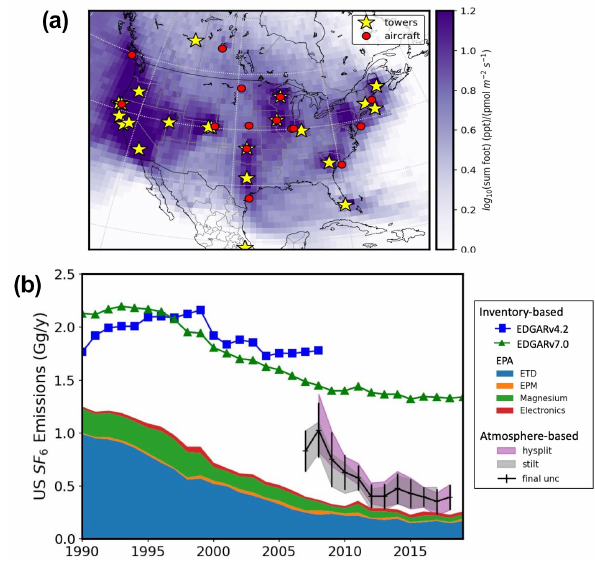
Figure 1. US SF 6 emissions derived from atmospheric observa- tions and reported by inventories. (a) Locations of atmospheric SF 6 measurements considered in the regional inversions; tower-based sampling is indicated as stars and airborne-profile sampling is de- noted as circles. Sensitivity of the atmospheric SF 6 measurements to surface emissions is indicated on a log10 scale as purple shading. (b) US SF 6 emissions reported by EDGAR (v4.2 and v7.0) and EPA inventories and derived from atmospheric observations. National to- tals are shown from EDGARv7.0, whereas the EPA inventory is parsed out by sector, including electric power transmission and dis- tribution (ETD), electrical equipment manufacturing (EPM), mag- nesium production, and electronics. Atmosphere-based emission es- timates for the contiguous United States (CONUS) are derived with two different model analyses of the atmospheric observations us- ing two different transport simulations (HYSPLIT–NAMS in purple shading for 2008–2018 and WRF–STILT in gray shading for 2007– 2017). The black line with error bars indicates inversion ensemble annual means and an uncertainty at a 95% confidence